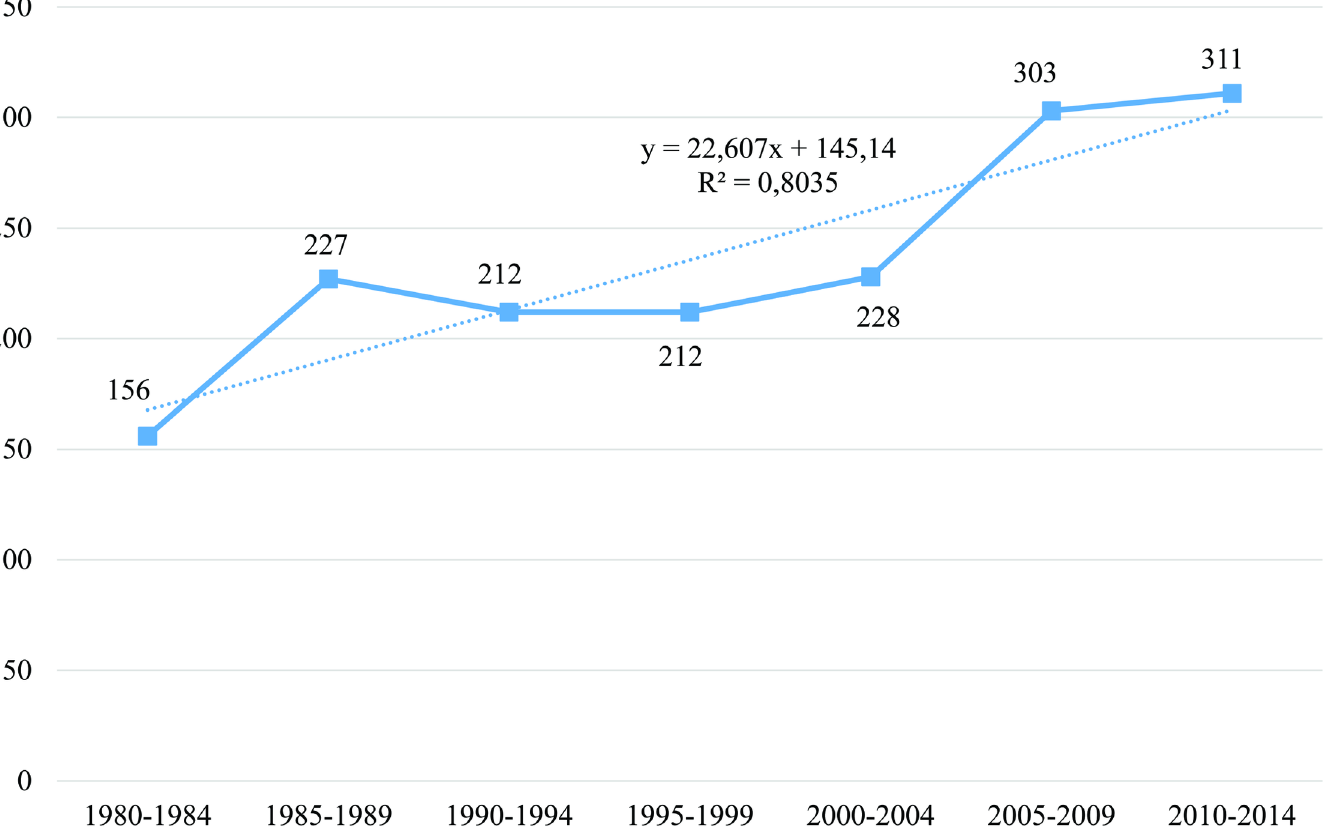
Fig 1. Evolution of number of documents on Chagas cardiomyopathy in the MEDLINE database (cid:3) . (cid:3) In the biennium 2015–2016, n = 76.